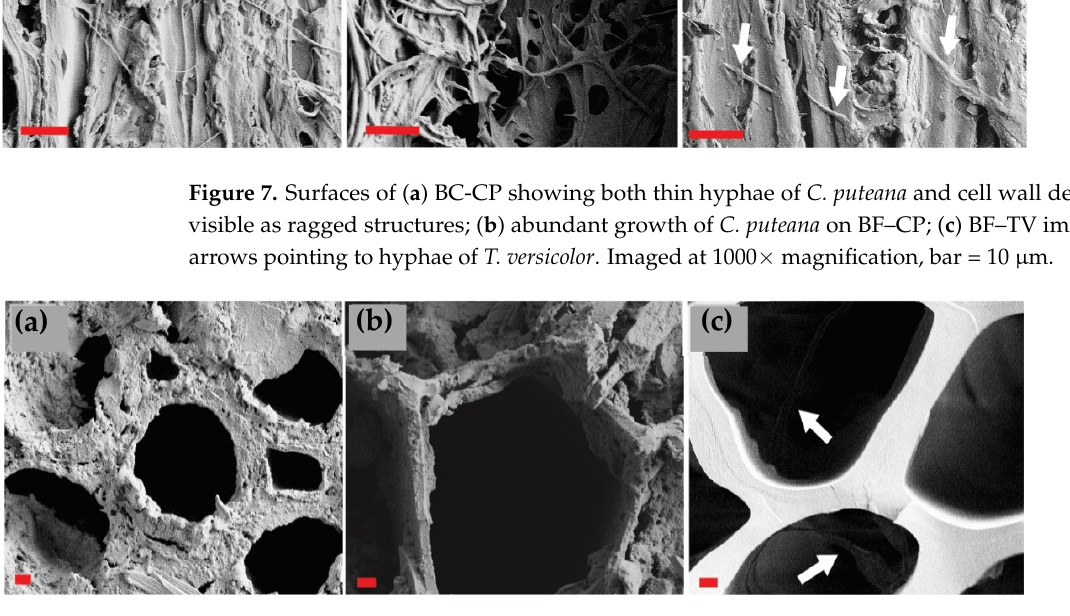
Figure 8. Modified layer cross-sections of ( a ) BC–TV; ( b ) SC-CP; ( c ) SF–CP with arrows pointing to faintly visible hyphae of C. puteana inside the lumens. Imaged at 2000×, bar = 2 µm.